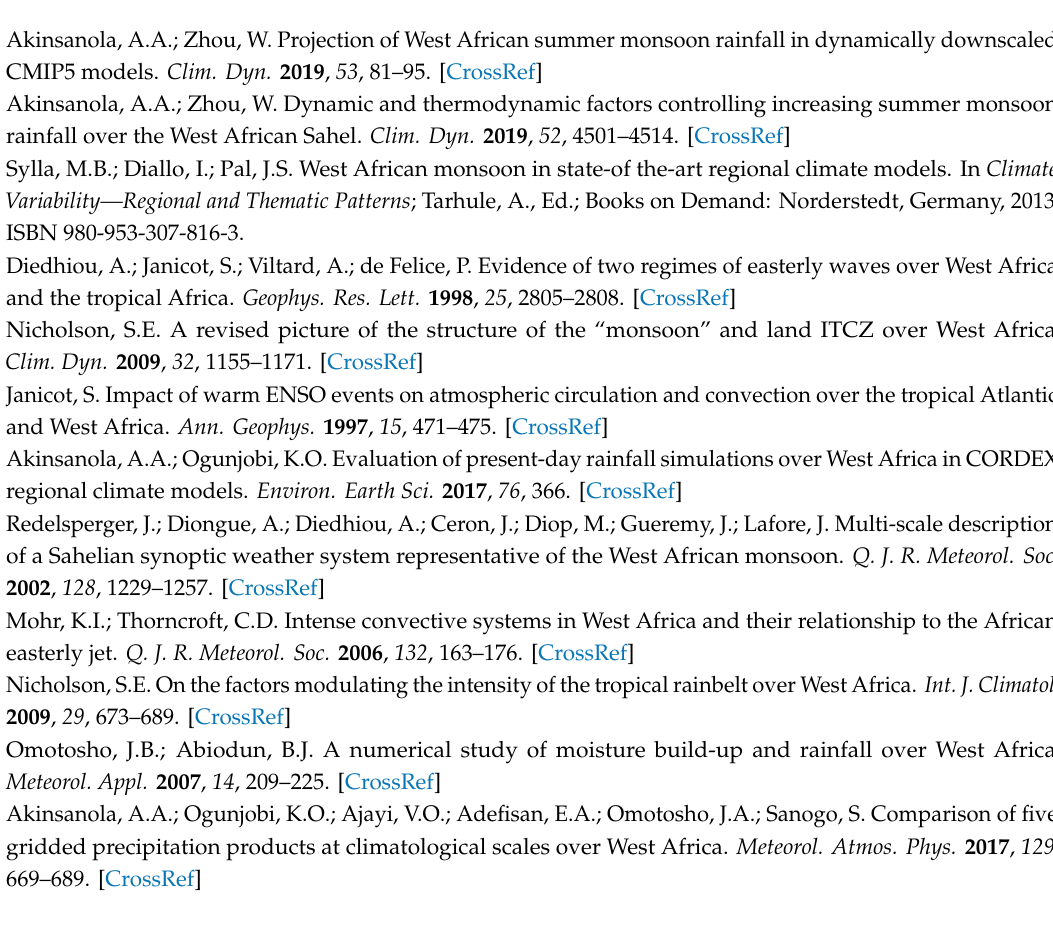
Figure S1: (a) Study domain showing West African topography and the regions designated as Guinea coast (A), Savannah (B), and Sahel (C), Figure S2: Standardized JJAS rainfall anomaly over West Africa from 1950–2014, Figure S3: Regression between JJAS zonal wind and area-averaged summer monsoon rainfall over West Africa (4–16 ◦ N, 20 ◦ W–20 ◦ E). Stippling indicates regions where changes are significant at the 95% level, Figure S4: Spatial correlation between previous indices and JJAS rainfall of (a) CRU, (b) GPCC, and (c) UDEL. Stippling indicates regions where changes are significant at the 95% level, Figure S5: Time series of the standardized anomaly of the WASMI and other